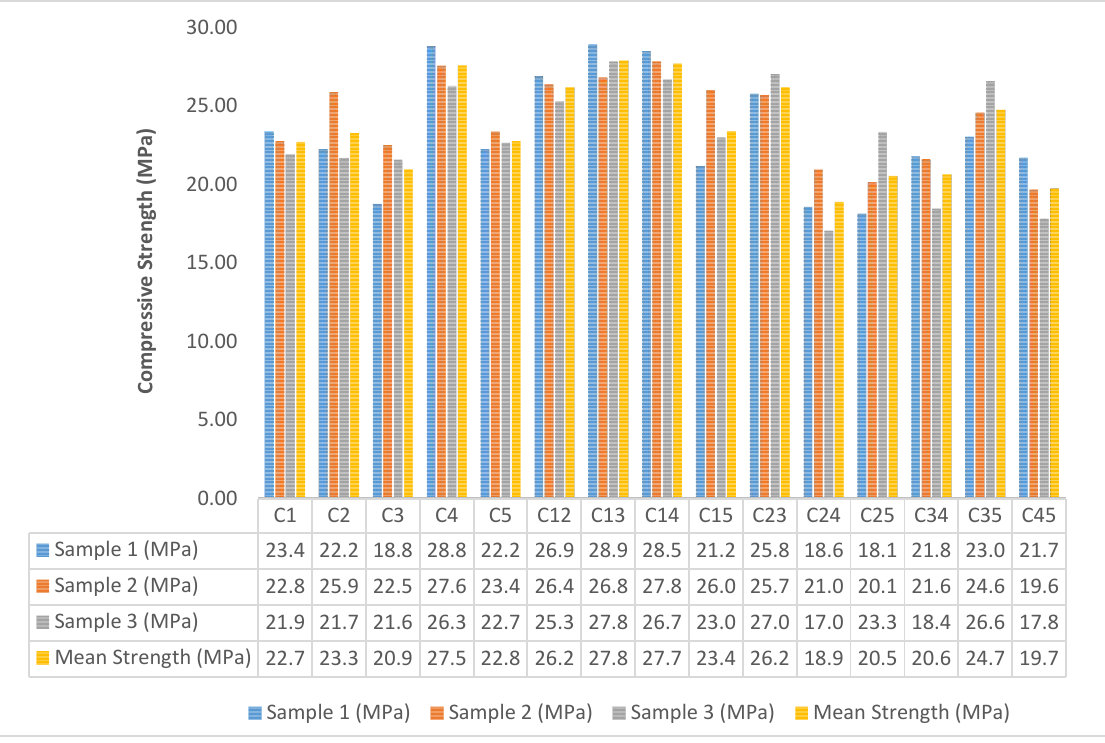
Fig. 3. The Compressive Strength (Laboratory Response, Yi) for the Control